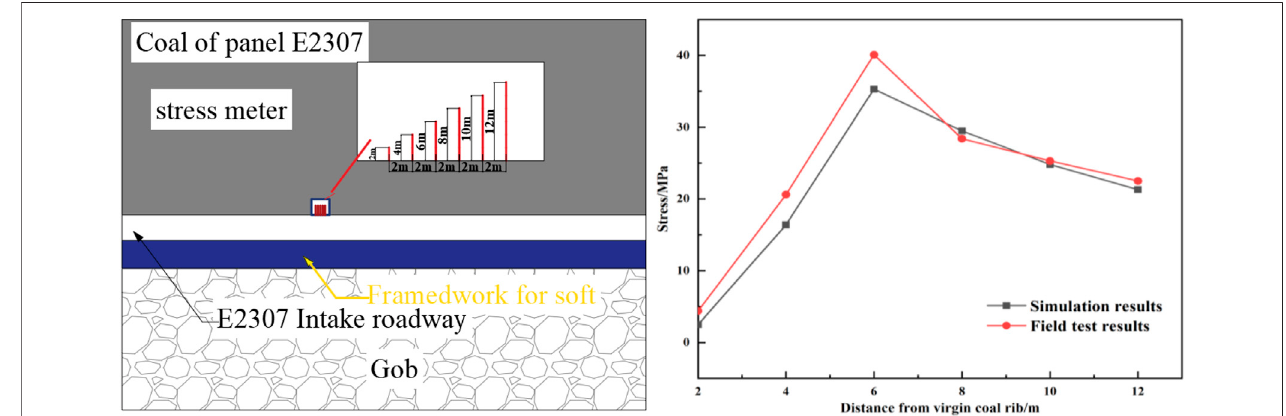
FIGURE 17 | On-site measurement and numerical veri fi cation of bearing stress.